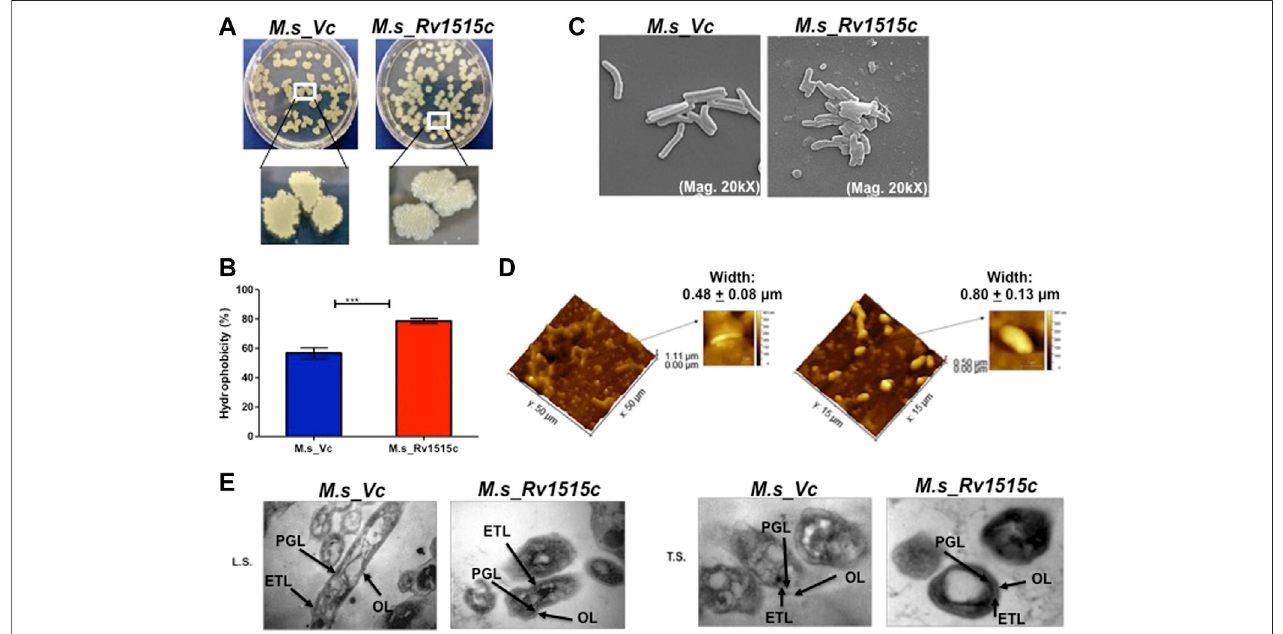
FIGURE 2 | Knock-in of Rv1515c gene in M. smegmatis modulates colony morphology, cell surface hydrophobicity and cell dimensions. (A) M. s _Vc and M. s _Rv1515c cells were plated on a 7H11 agar plate and incubated at 37 ° C for 3 days to allow colony formation. (B) M. s _Vc and M. s _Rv1515c cells pellets were subjected to Hexadecane partitioning assay and cell surface hydrophobicity of bacterial cells were analyzed. (C) SEM imaging (20kX) of M. s _Vc and M. s _Rv1515c for assessingthelengthofbacteria.SEMdatawereanalyzed withXEISSsoftware. (D) AFM imagingtoanalyzethetopologyof M.s _Rv1515cand M.s _Vccells. Inset is the enlarged three-dimensional view of bacterial surface topology. AFM data were analyzed by Gwyddion software. (E) TEM anslysis of Ultrathin structure (LS: longitudinal section; TS: transverse section) of M. s _Vc and M. s _Rv1515c revealed cell wall modi fi cation. OL (Outer layer), PG (Peptidoglycan), and ETL (Electron transparentlayer).Dataarerepresentedasmean±SDoffrom threeindependentexperiments, andstatisticalanalysiswasperformed usingatwo-tailedunpairedt-test. *** p <